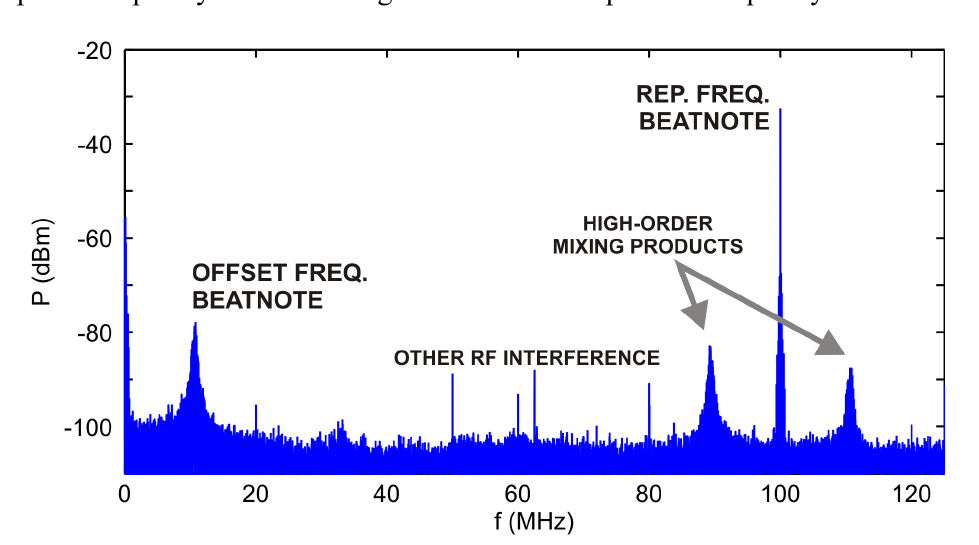
Figure 4. A typical power spectrum of the f-2f signal produced by an f-2f stage connected to an optical frequency comb working with 100 MHz repetition